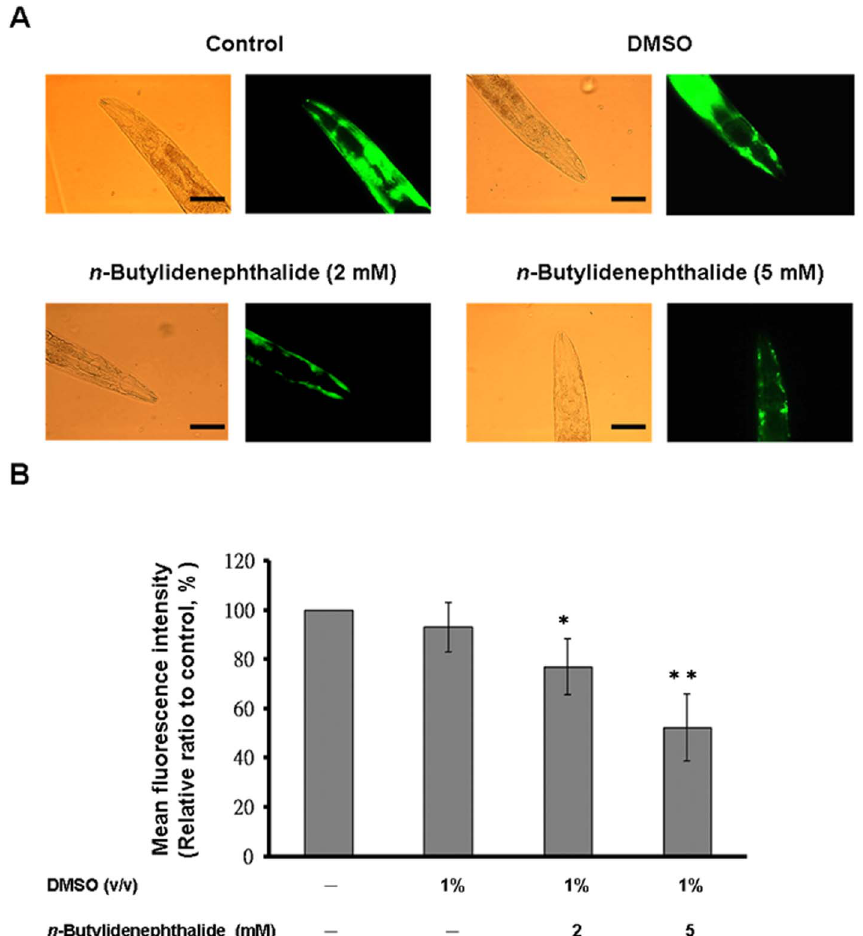
Figure 4. n -Butylidenephthalide reduces a -synuclein accumulation in the OW13 strain of C.elegans . (A) YFP expression pattern in muscles of transgenic C. elegans strain OW13. The left side shows the differential interference contrast (DIC) image. The right side shows fluorescence images. Scale bar, 50 m m. (B) Graphical representation for fluorescence intensity of YFP expression pattern in muscles of transgenic C. elegans strain OW13 as quantified using AxioVision software. The data represent the mean 6 SD (n=10). An asterisk (*) indicates significant differences between the control samples and the n -butylidenephthalide-treated samples ( * p , 0.05, ** p , 0.01).